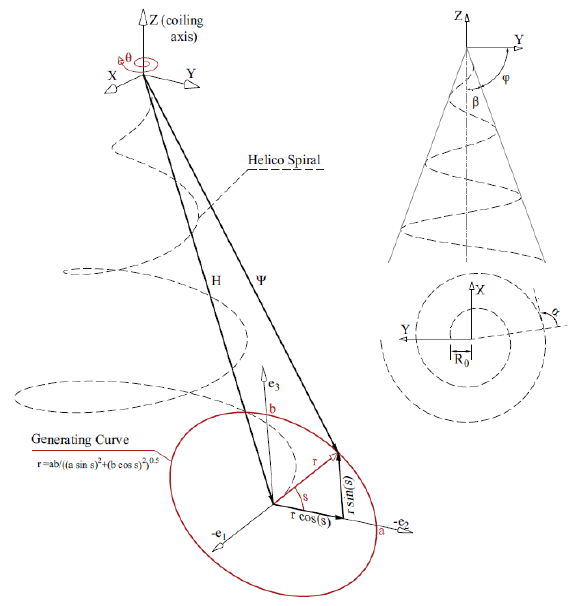
Figure 3. Diagram of shell variables. Reproduced with permission from [29], Elsevier, 2012.